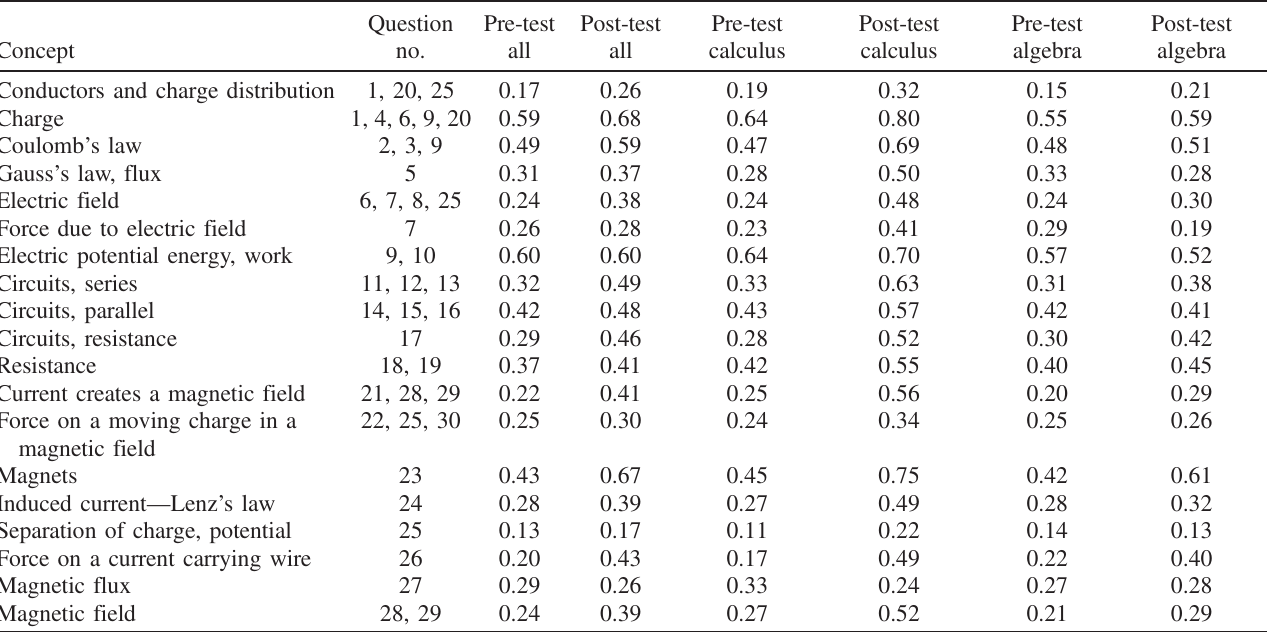
TABLE I. Conceptual topics and corresponding question numbers, with pre- and post-test results (number of students that answered correctly out of total number of